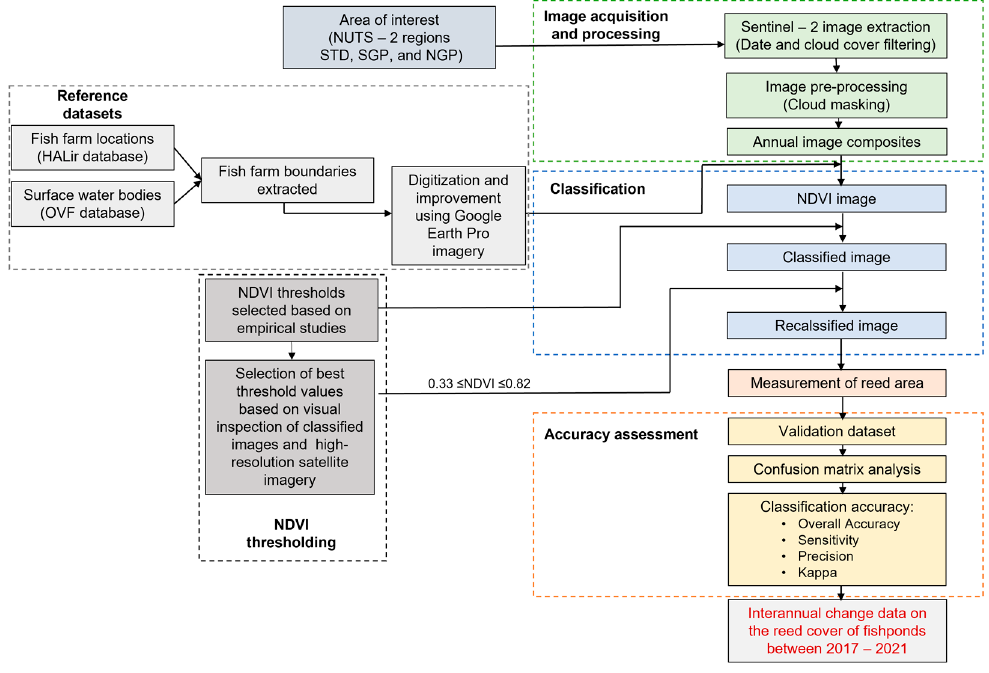
Figure 4. Work fl ow of the reed cover estimation methodology. Figure 4. Workflow of the reed cover estimation